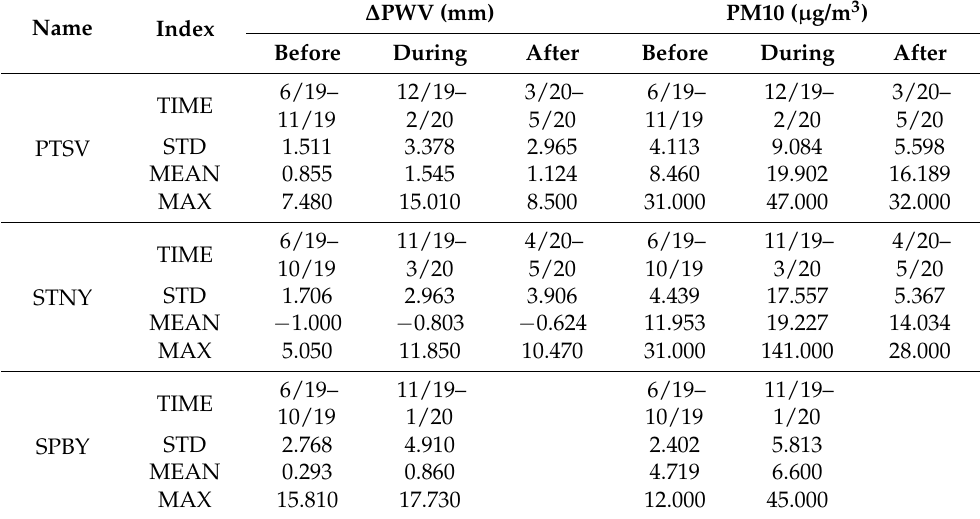
Table 4. The statistical results of the difference between GNSS-derived precipitable water vapor and radiosonde-derived precipitable water vapor ( ∆ PWV) and PM10 before, during, and after forest fire. The format of Time is: month/year. For example, “6/19–11/19” means from June 2019 to November